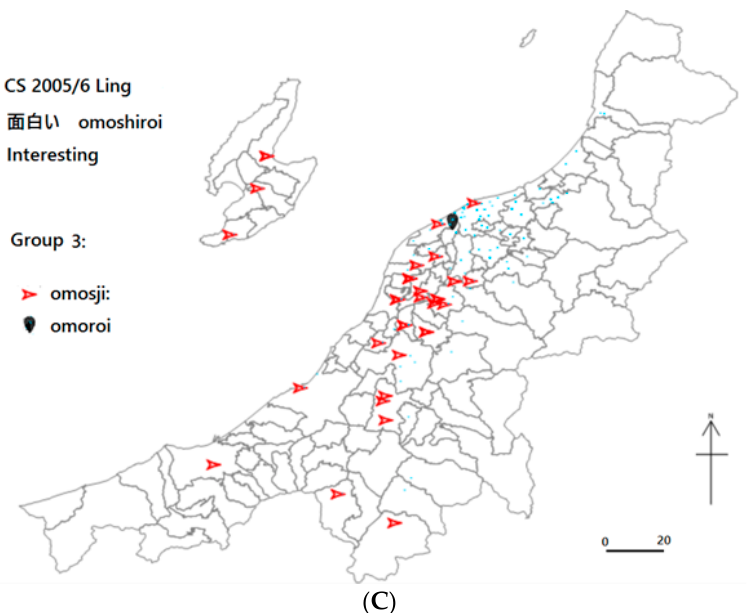
Figure 9. ( A ) Map (Group 1) of omoshiroi “interesting” in Niigata: 2005 / 6 CS Survey. ( B ) Map (Group 2) of omoshiroi “interesting” in Niigata: 2005 / 6 CS Survey. ( C ) Map (Group 3) of omoshiroi “interesting” in Niigata: 2005 / 6 CS Survey.